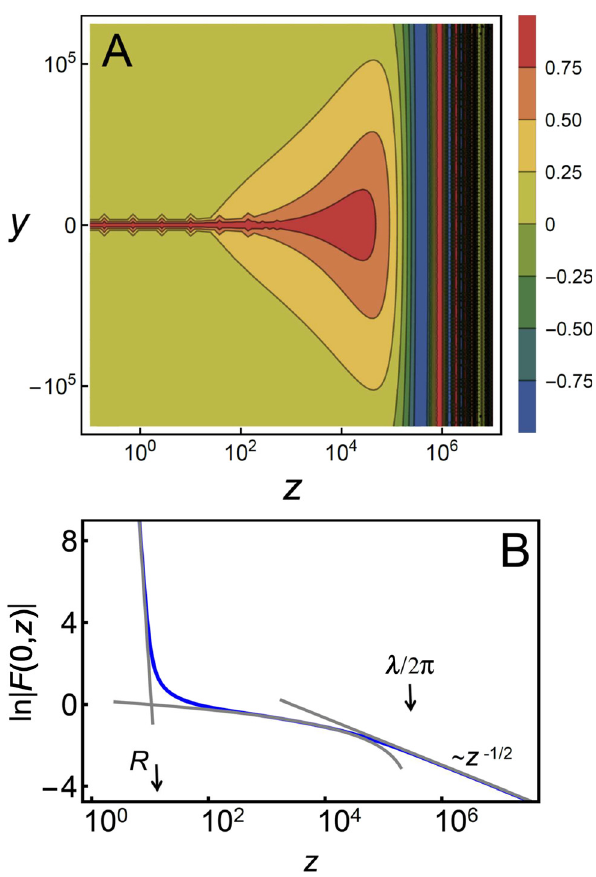
Figure 1: Near and far field of a one-dimensional metasurface; see Eq. (10). (A) Contour plot of the normalized fi eld, Re[ F ( y , z )]/ | F (0, z ) | , for N =20, R =10and λ (cid:2) 10 6 .(B)ln | F (0, z ) | versus z (bluecurve).Gray curves are asymptotes. For small and intermediate distances from themetasurface, F ∝ z − N and F ∝ ln z ( 10 2 ≲ z ≲ 10 5 ) .Thesenear- fi eld forms correspond, respectively, to the small argument limit of H ( 1 ) (cid:5) √ N and H ( 1 ) . In the far fi eld, z ≳ 10 5 , F ∝ 1 / z 0